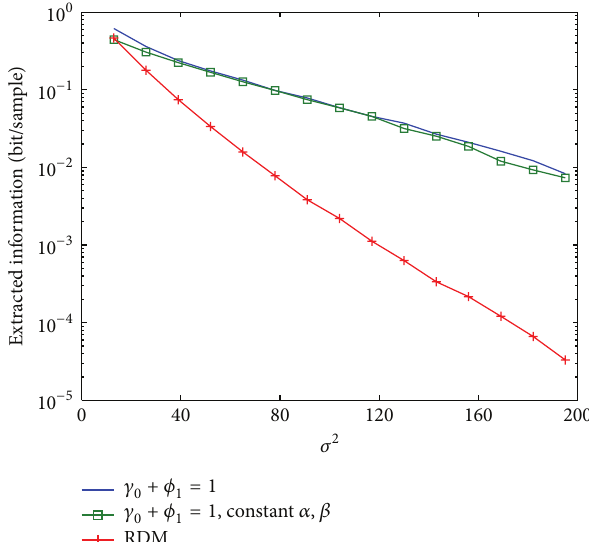
Figure 9: Information extracted under GA followed by AWGN.